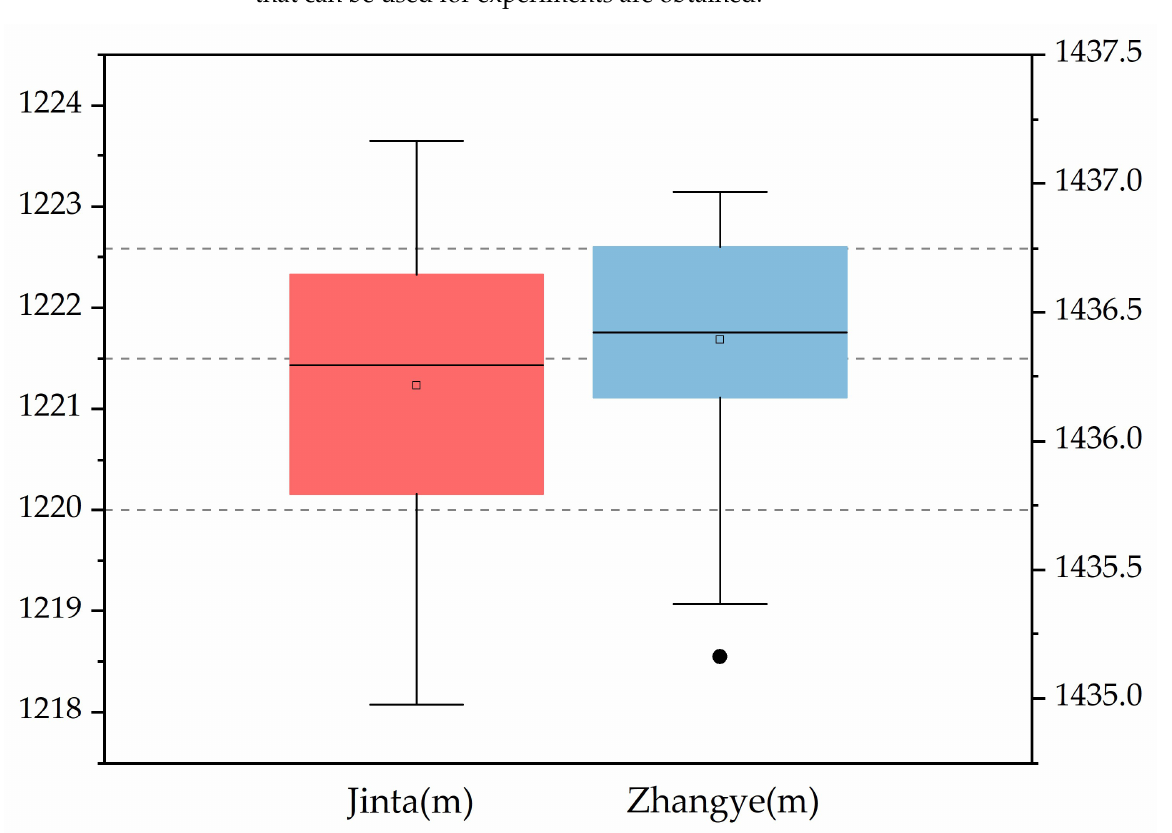
Figure 3. Box Plot Analysis Outlier Process.